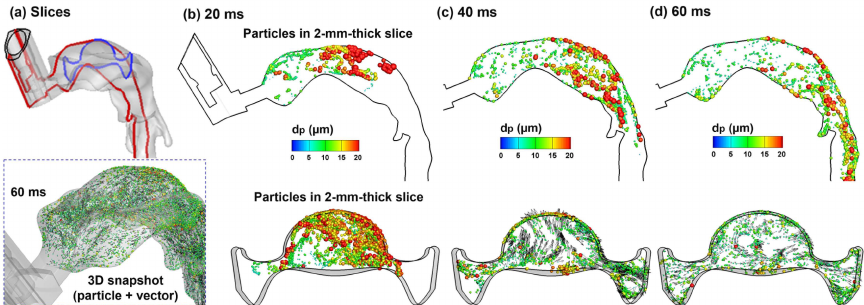
Figure 6. Droplet dynamics within the oral cavity 20–60 ms after MDI actuation within a 2 mm–thick slice: ( a ) two sampling locations, namely a sagittal slice (red, mid-plane) and an axial slice (blue); and snapshots of droplets in the sagittal and axial slices at three instants: ( b ) 20 ms, ( c ) 40 ms, and ( d ) 60 ms. Symbols of droplets were colored and scaled by their sizes.